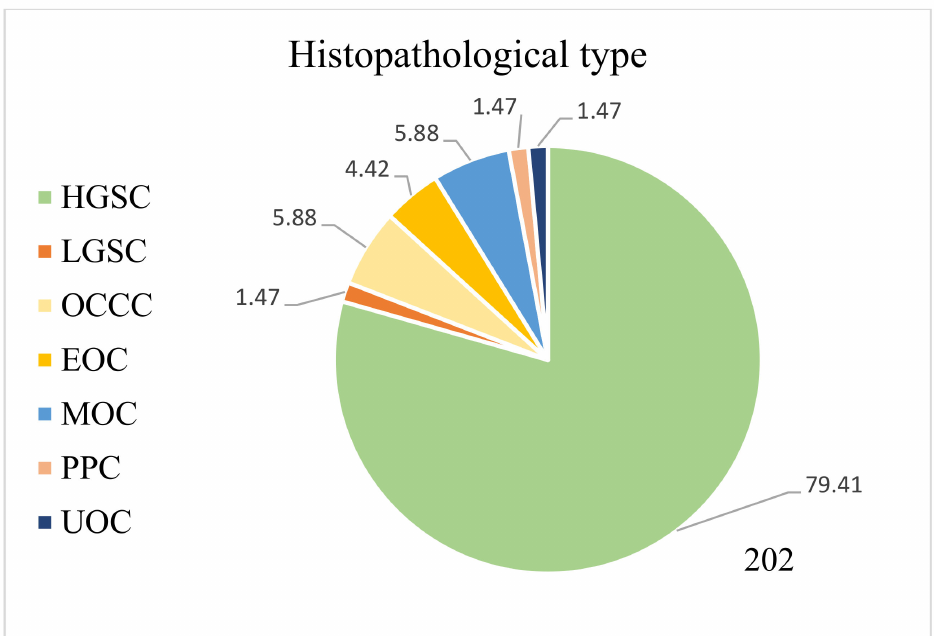
Figure 3. Histopathological types of OC in patients admitted in the year 2020. HGSC—high- grade serous carcinoma; LGSC—low-grade serous carcinoma; OCCC—ovarian clear-cell carcinoma; EOC—endometrioid ovarian cancer; MOC—mucinous ovarian cancer; PPC—primary peritoneal cancer; UOC—undifferentiated carcinoma of the